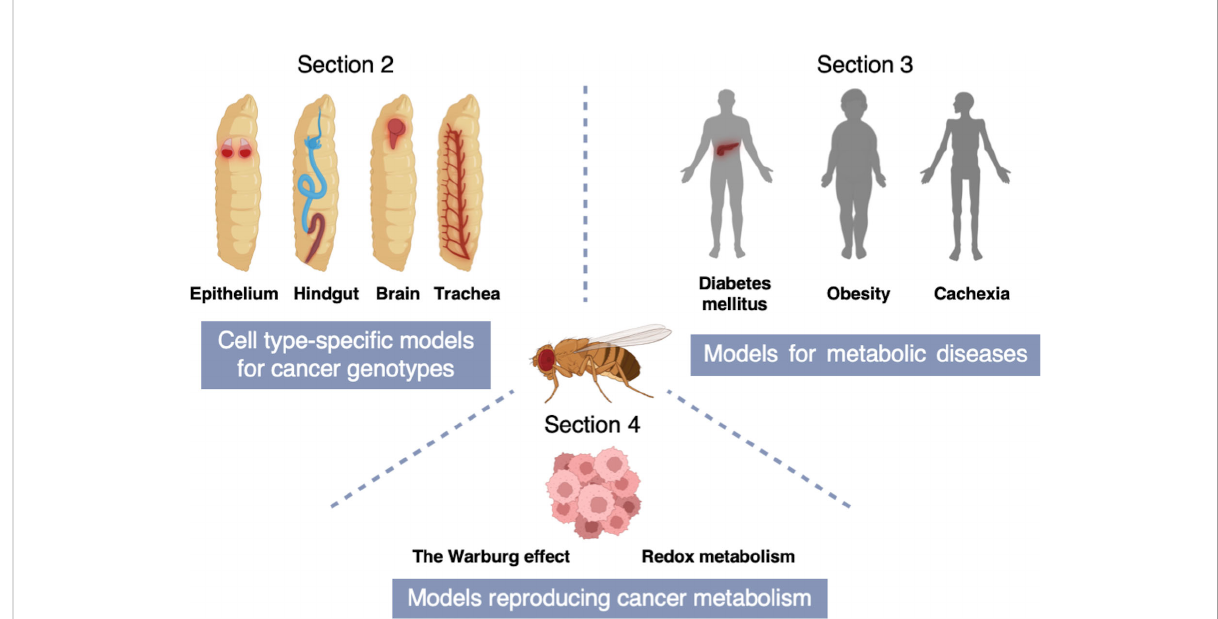
FIGURE 2 A schematic of the structure of this review. Section 2 describes cell type-speci fi c models for cancer genotypes to mimic equivalent cancers in speci fi c fl y tissues [Adenoid cystic carcinoma (AdCC) and thyroid cancer (TC) in the fl y wing disc epithelium; Colorectal cancer (CRC) in the fl y hindgut; Non-small cell lung cancer (NSCLC) in the fl y trachea; Glioblastoma (GBM) in the fl y brain]. In Section 3, we introduce fl y models for metabolic diseases including obesity, cachexia, and diabetes mellitus. Section 4 indicates fl y models reproducing cancer metabolism which provide novel insights into the Warburg effect and redox